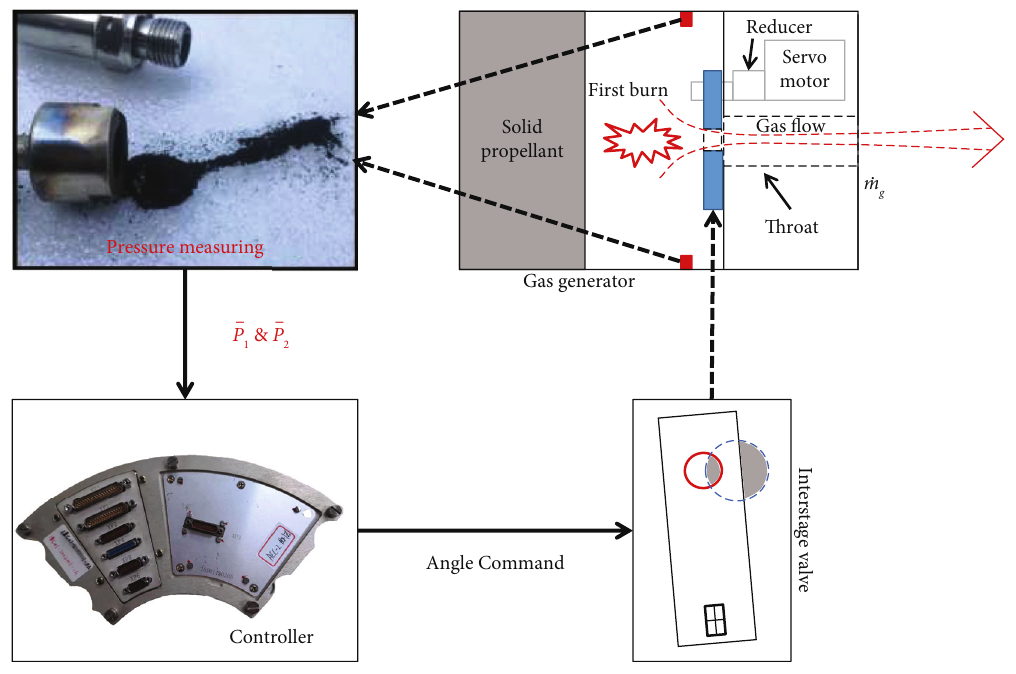
Figure 1: The structure and working principle of the